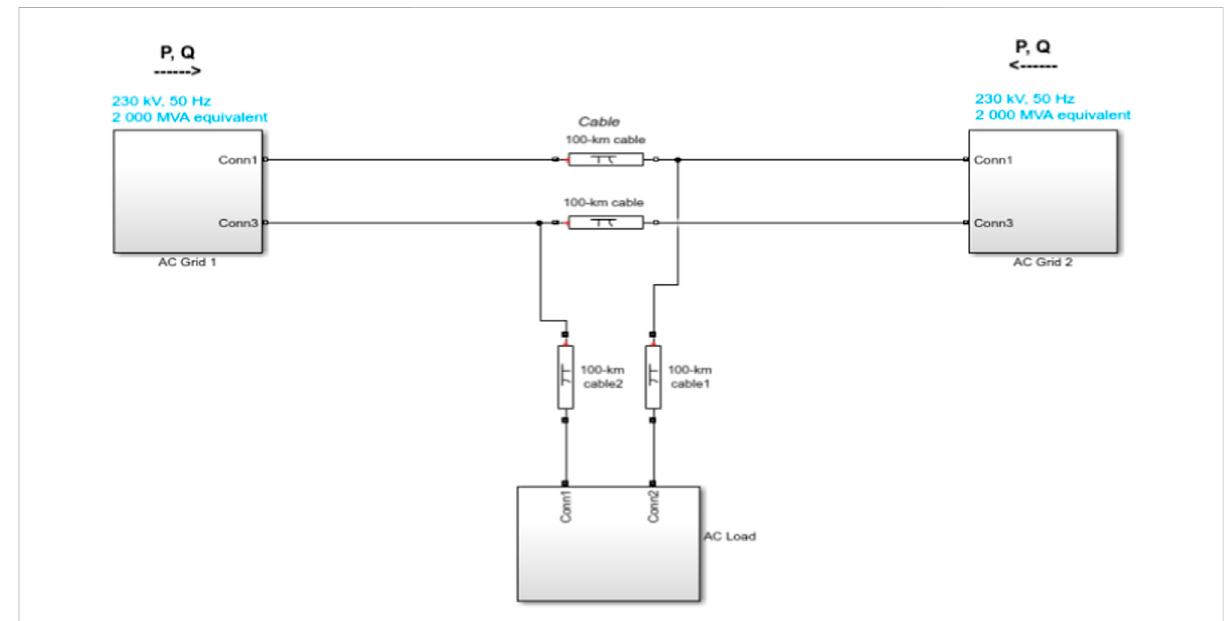
FIGURE 12 Three terminal MTDC